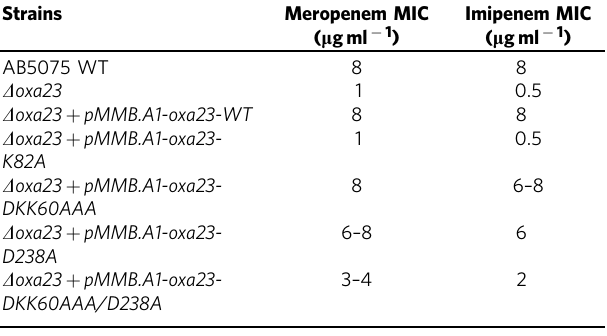
Table 2 | MICs for D oxa23 complementation